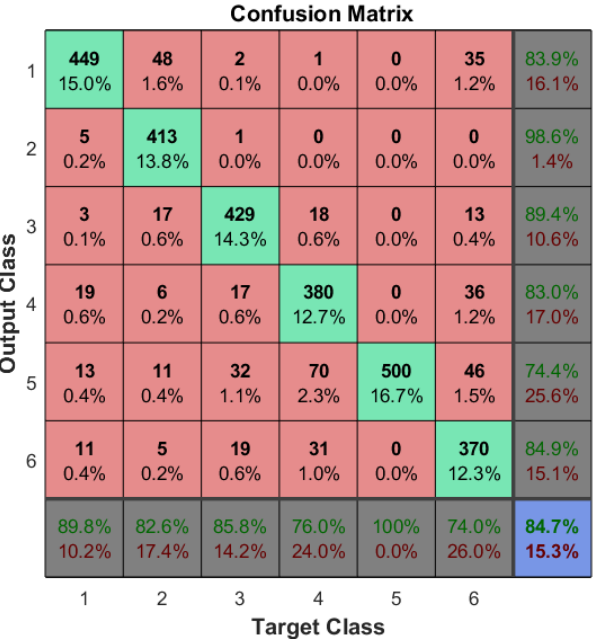
Figure 11. Confusion matrix evaluating the default classifier of the